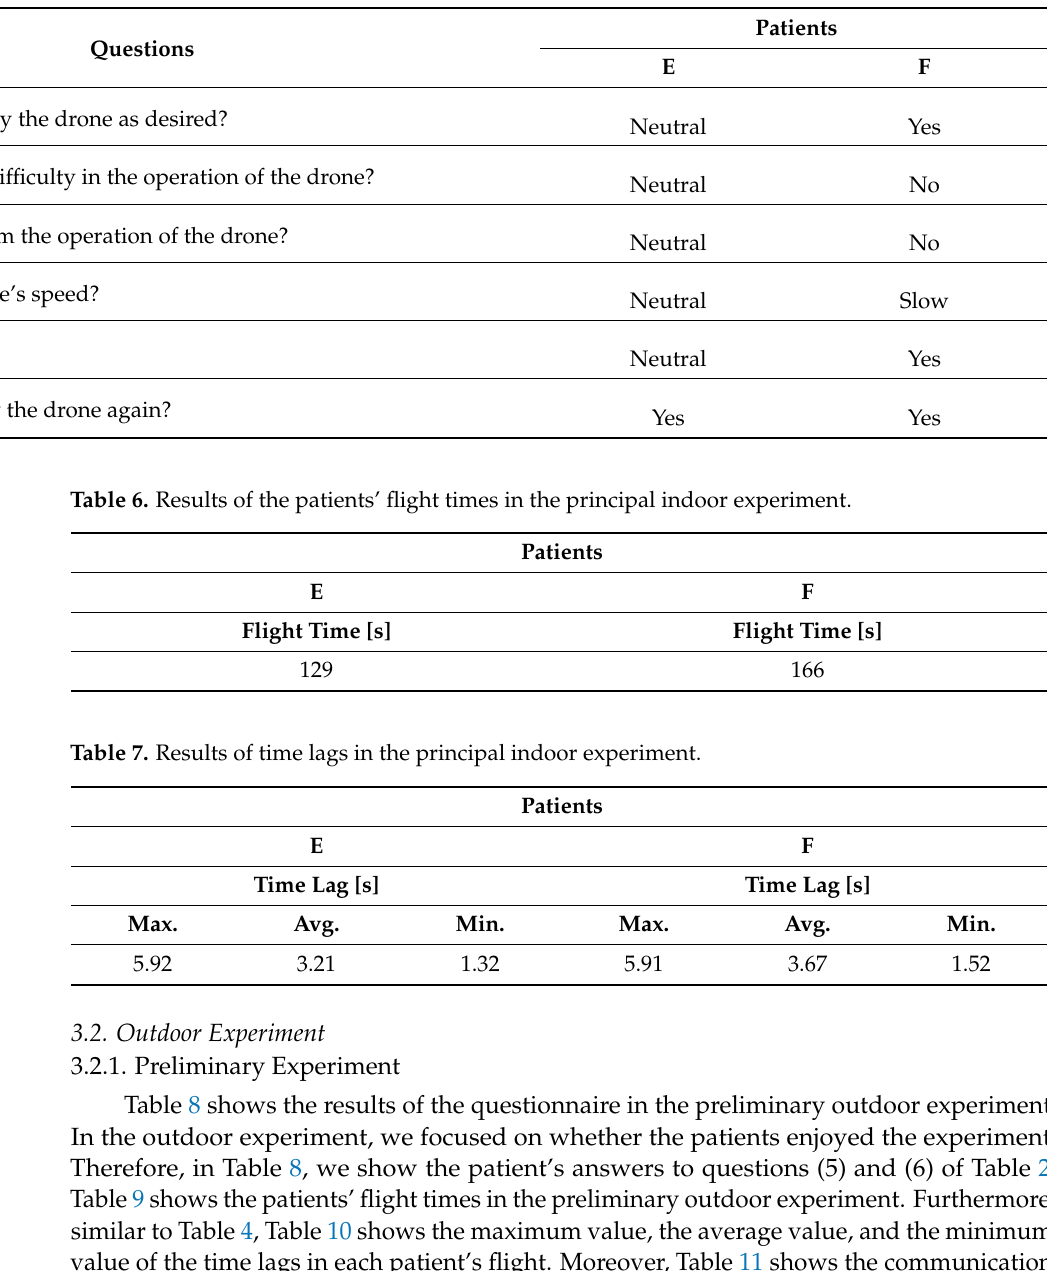
Table 5. Questionnaire results in the principal indoor experiment.